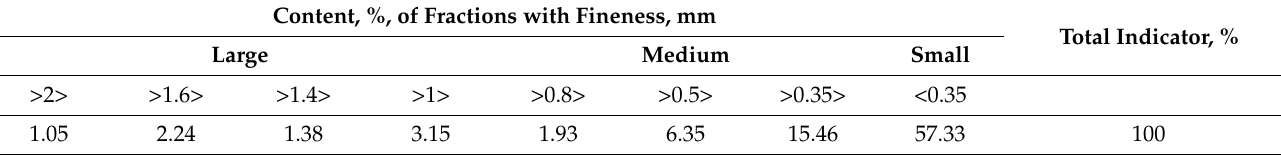
Table 2. Granulometric composition of the process sample.